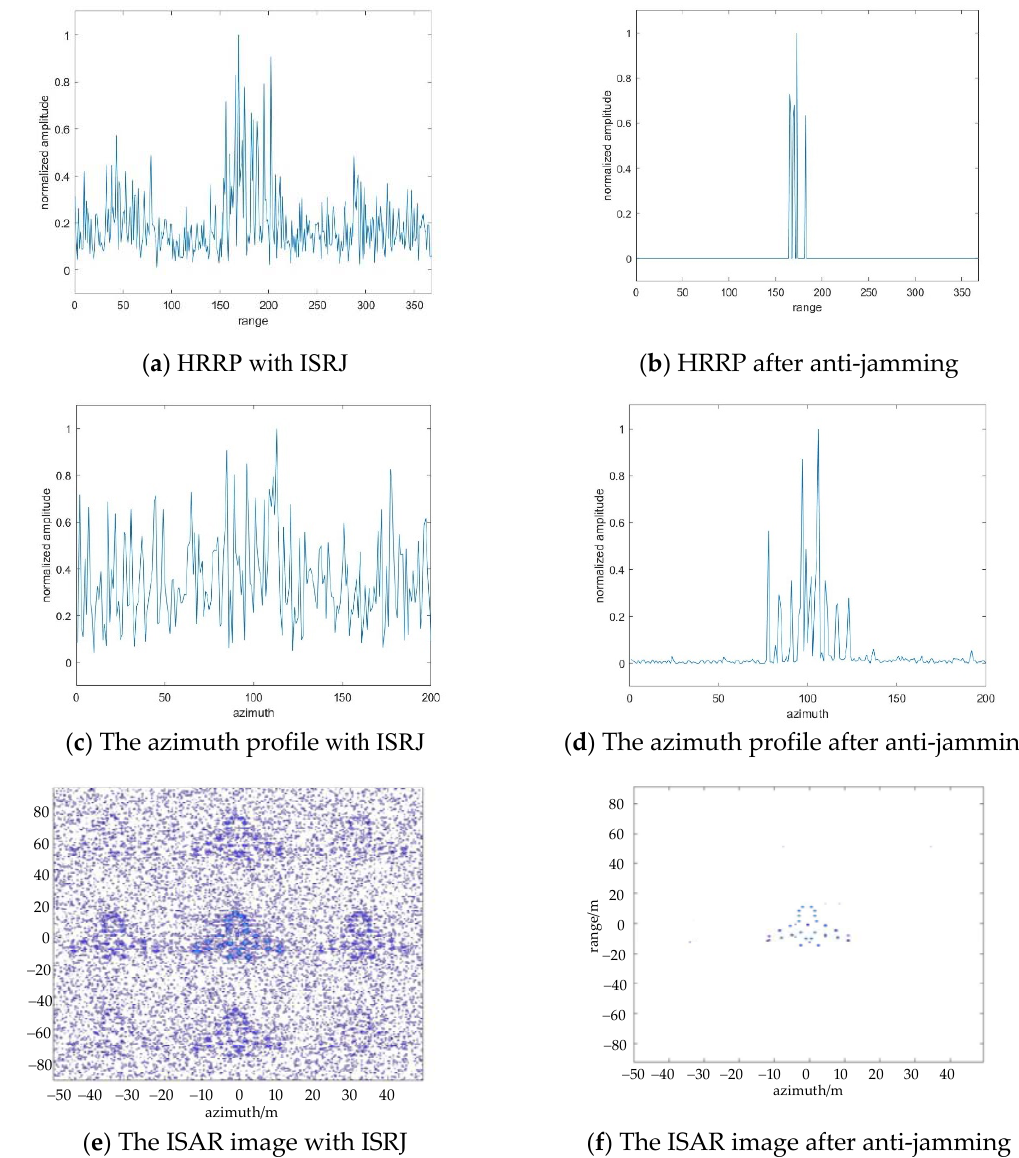
Figure 11. The results of ISRJ jamming and anti ‐ jamming in the fast and slow time domain with JSR 20dB and SNR ‐ 20dB .